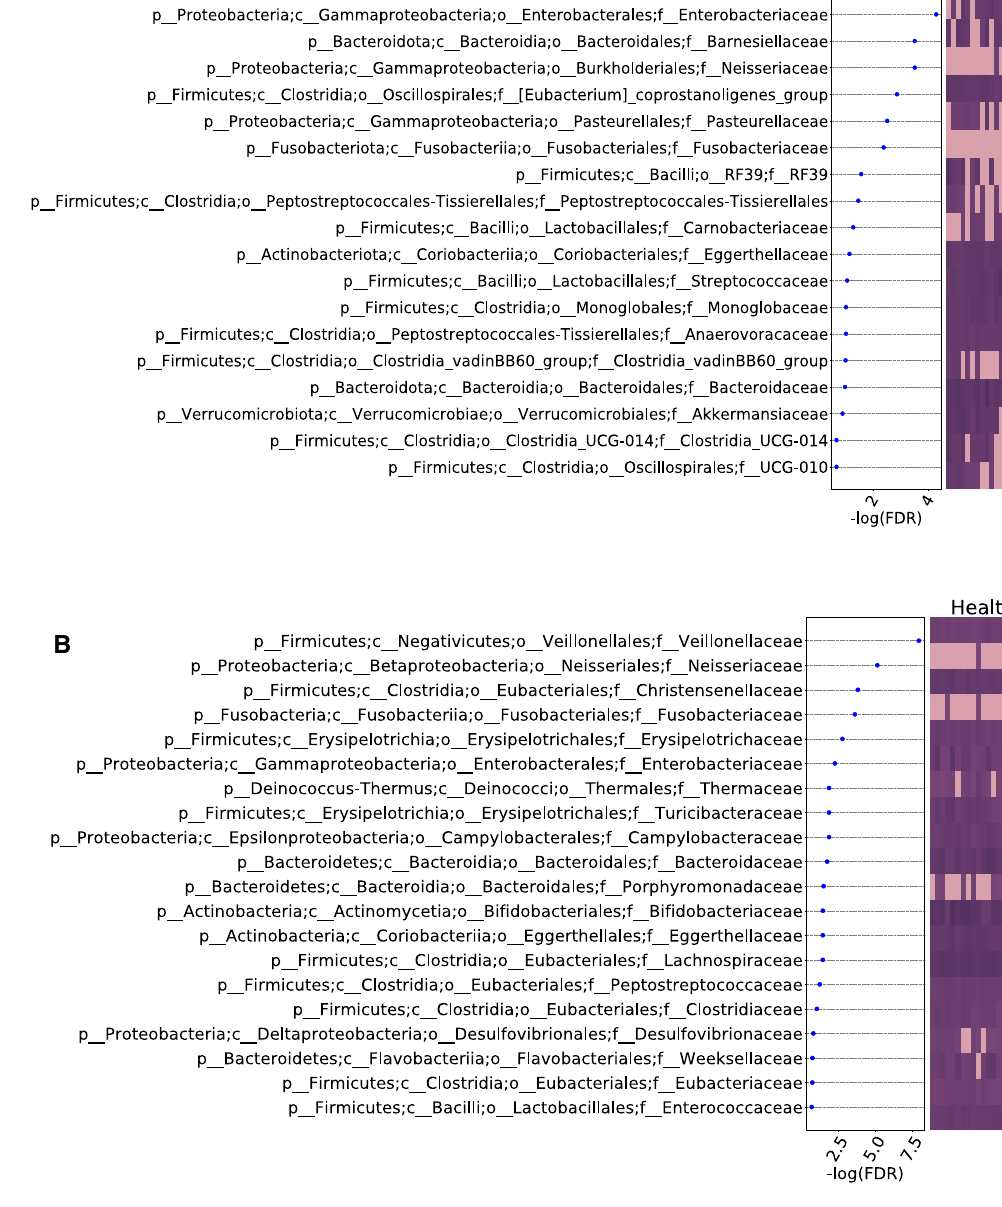
Figure 3. Bacterial families associated with pediatric UC ranked according to their statistical significance and heatmap using the ( A ) 16S, ( B ) shotgun profiling data. Each row represents a bacteria family. The left panel is dot plot of negative log10 transformed FDR value and the right two panels are heatmaps of abundance with log transformation for healthy controls and UC cases. Purple indicates high abundance, while pink indicates low